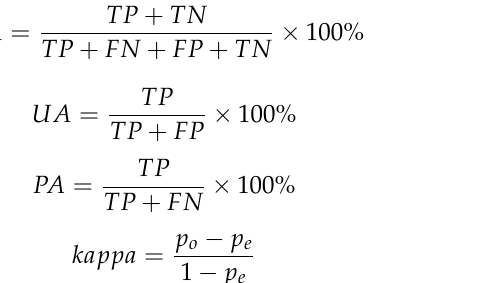
Table 4. Comparison of classification accuracy of seven models.